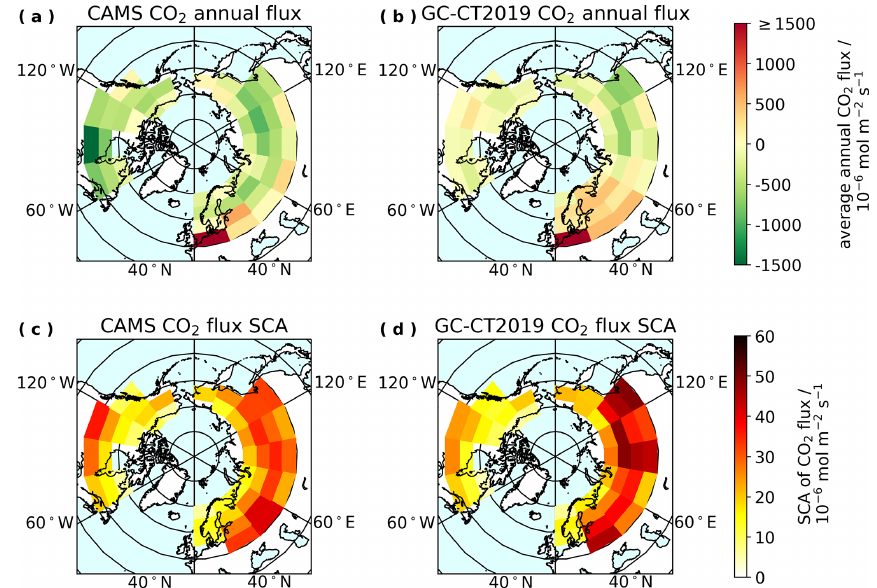
Figure 11. Maps of average total annual CO 2 flux, using GC-CT2019 (GC) and CAMS flux estimates (a, b) , and SCA in CO 2 flux, calculated as the difference between the maximum and minimum of the average annual cycle in flux (c, d)